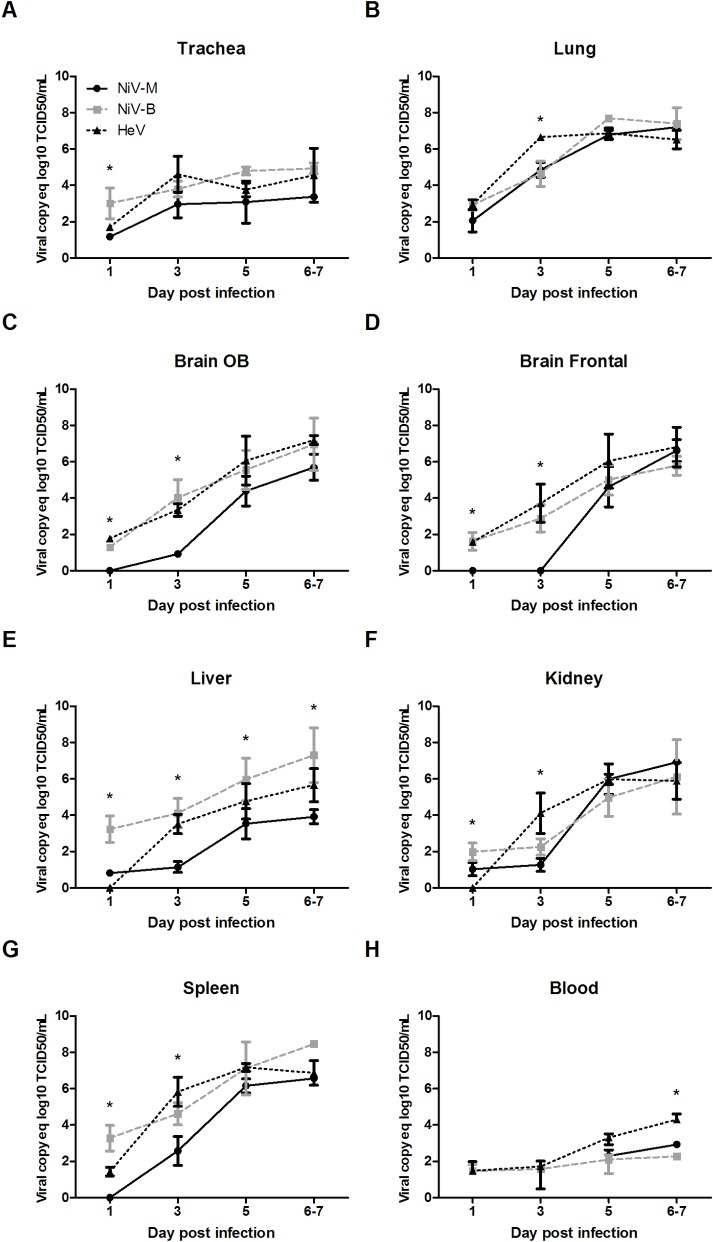
Viral spread across body compartments in henipavirus infected ferrets.A comparative study using a dose of 5,000 TCID50 for each of the three viruses was performed in ferrets: viral growth in the ferret tissue, as measured by quantitative RT-PCR in the trachea (A), lung (B), olfactory bulb (C), frontal brain (D), liver (E), kidney (F), spleen (G), and blood(H); tissues were harvested from 6-week old ferrets infected with NiV-B (grey), NiV-M (black solid) and HeV (black dashed) on various days post infection as described in Materials and Methods. Samples from 5 animals per group were analyzed at each time point. * p<0.01, two-way ANOVA, Bonferroni’s multiple comparison test. Error bars represent standard deviations.